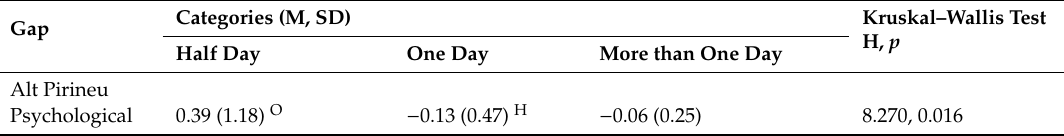
Table A3. Post hoc comparisons for the GAPs between expected benefits and satisfaction according to duration of